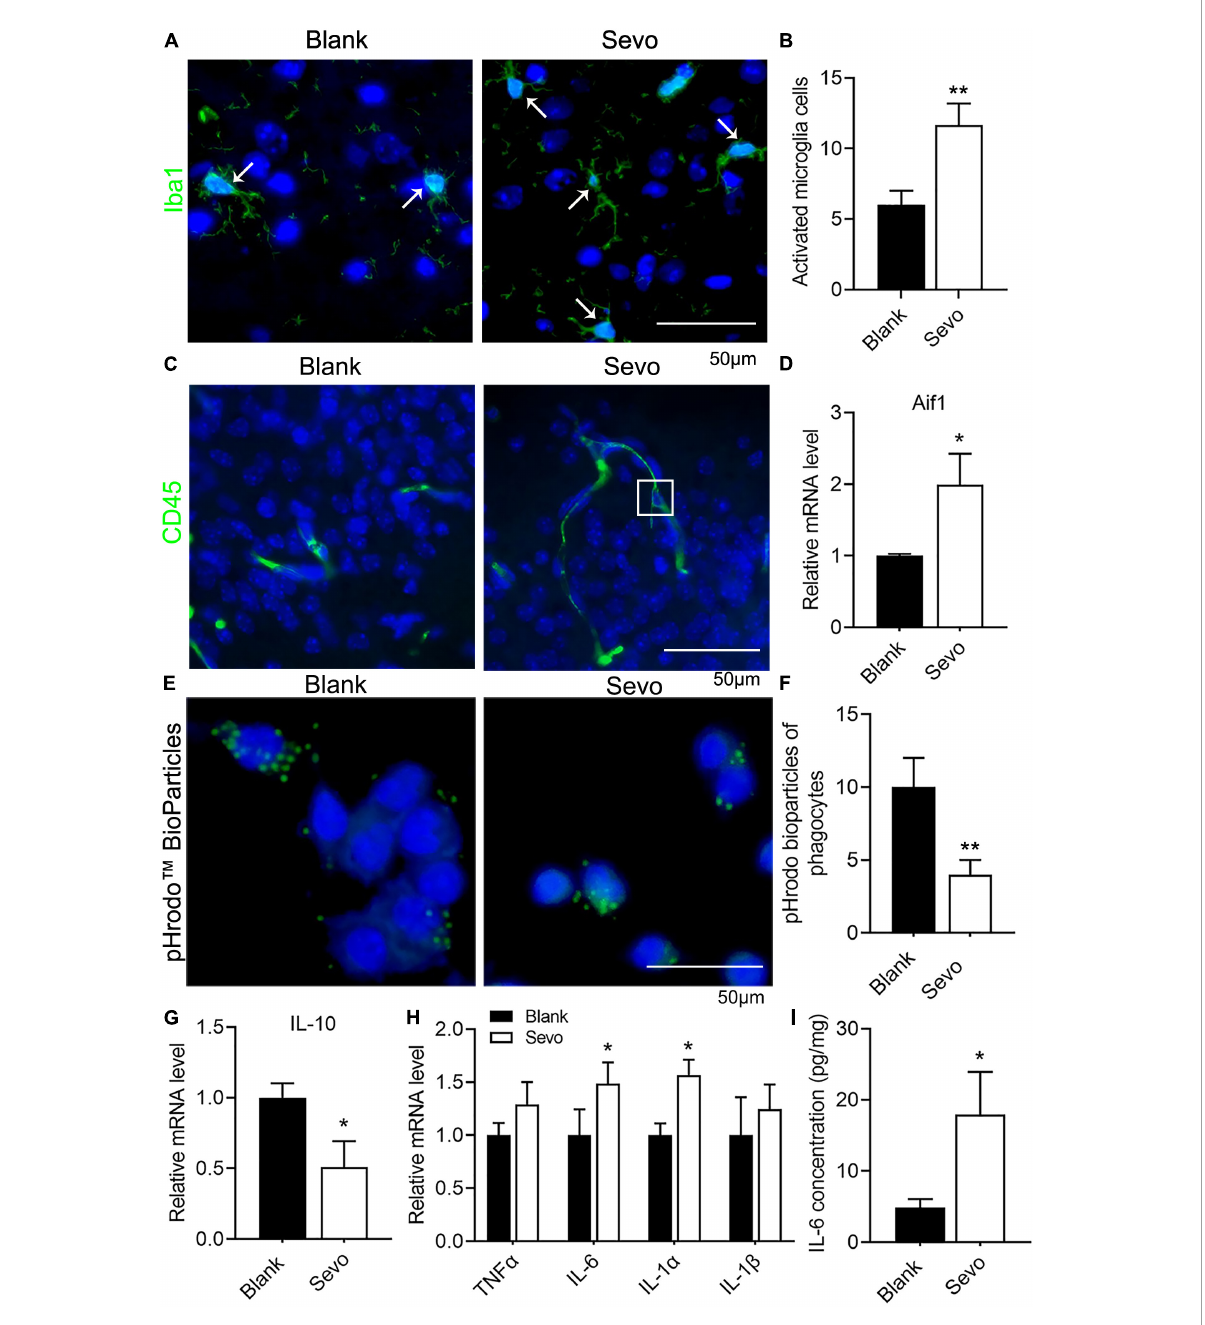
FIGURE2 Sevoflurane exposure resulted in microglia activation and phagocytic dysfunction. (A,B) Immunofluorescence and quantitative analysis with Iba1 of brain tissue. p = 0.013. N = 3. (C) Immunofluorescence with CD45 of brain tissue. (D) qRT-PCR of BV-2 cell line shows the mRNA level of Aif1. p = 0.053. N = 3. (E,F) pHrodo TM Green BioParticles staining and quantification of BV-2 cell line to determine the phagocytic function. p = 0.01. N = 6. (G) qRT-PCR of BV-2 cell line indicates the mRNA level of IL-10. p = 0.045. N = 3. (H) qRT-PCR of BV-2 cell line shows the mRNA level of proinflammatory factors. p(TNF α ) = 0.1, p(IL-6) = 0.059, p(IL-1 α ) = 0.017, p(IL-1 β ) = 0.39. N = 3. (I) IL-6 ELISA experiment of BV-2 cell line both in control and sevoflurane group. p = 0.036. N = 4. Scale bar, 50 µ m. * P ≤ 0.05, ** P ≤